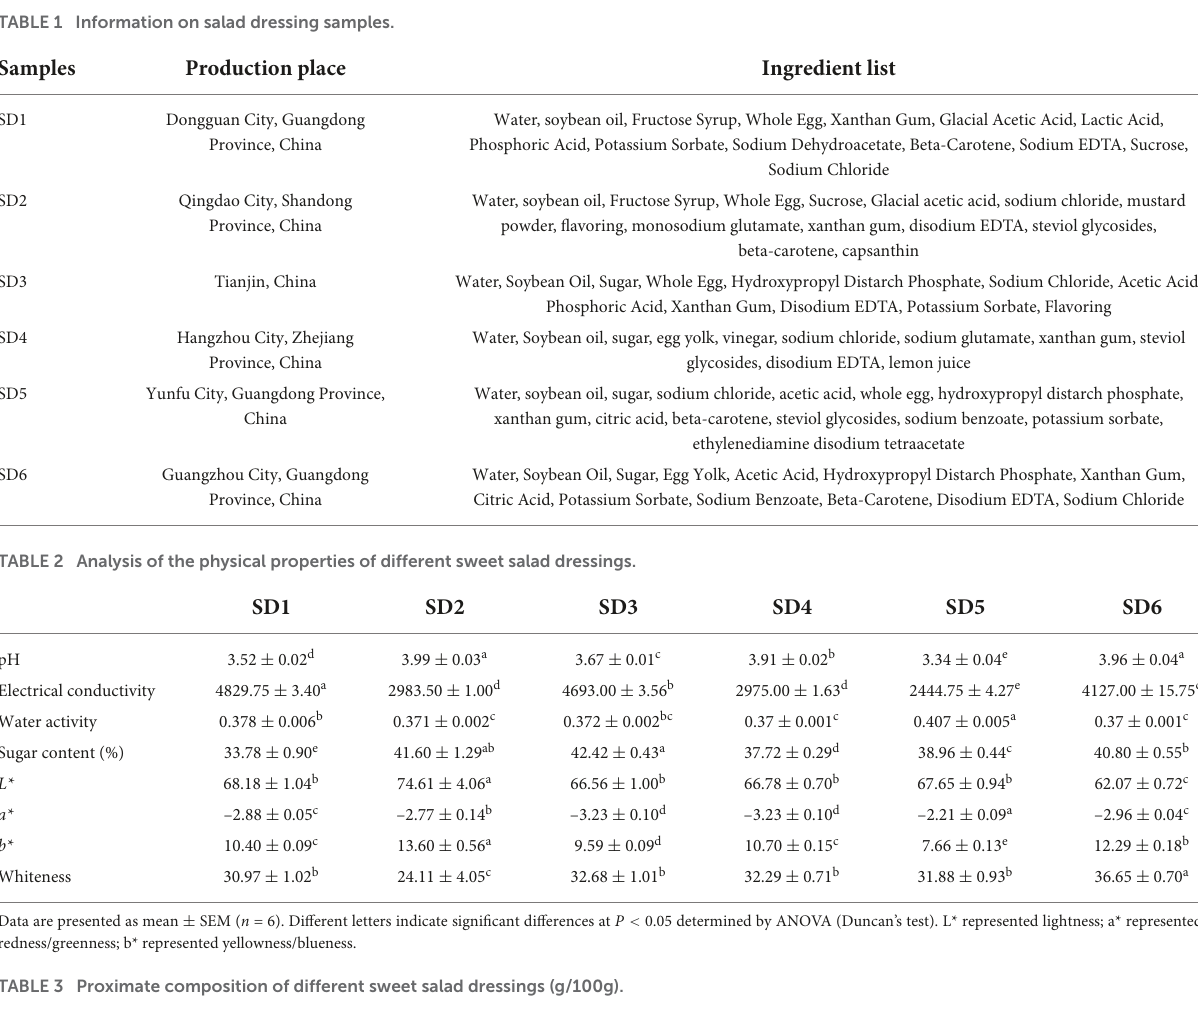
TABLE 1 Information on salad dressing samples.